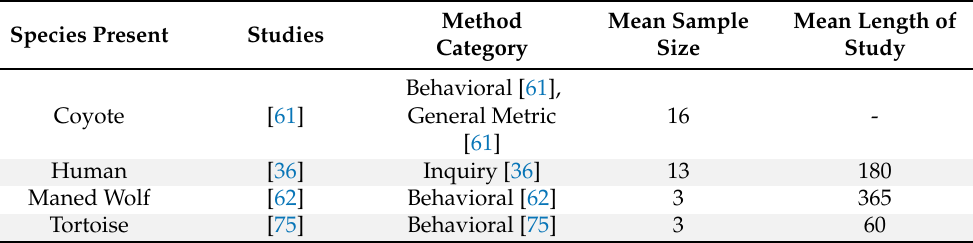
Table 5. Species and measurements break down for wildlife animals. The mean study length column represents the average time (in days) of study procedures. Shading added to aid readability. Species Present